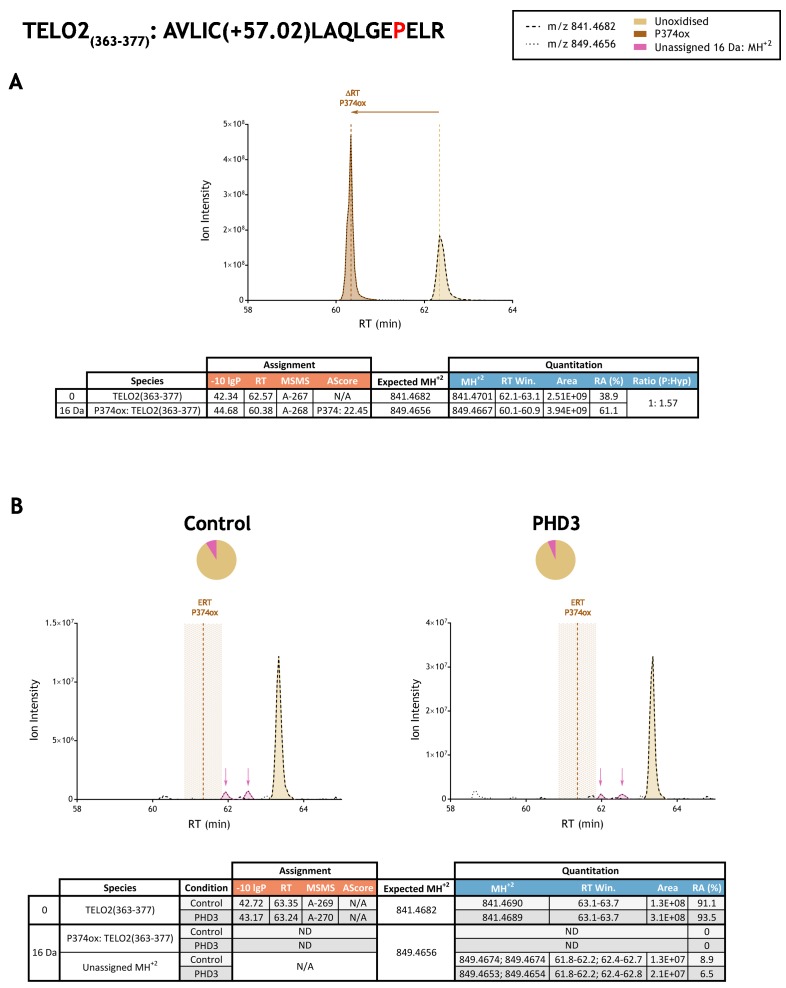
Quantitation of peptide oxidation on TELO2(363–377) following reaction of full-length telomere maintenance 2 with recombinant PHD3.XIC data presented in (A) shows ion intensity and retention time (RT) characteristics of equimolar synthetic peptide standards for unoxidised and P374ox forms of the TELO2(363–377) peptide. MSMS assigned species are coloured (see inset); vertical dashed lines define peak maxima used to derive ΔRT values for P374ox. Panel (B) shows comparable XIC data for protease-digested IVTT substrate under control (left) or PHD3-reacted (right) conditions. Peaks corresponding to unoxidised TELO2(363–377) were assigned by MSMS (see inset for colour code); P374ox was not detected. The estimated RT (ERT) for P374ox, derived from (A), is indicated by dashed vertical line, shading corresponds to a 1 min RT window. Unassigned ions of compatible mass over charge for hydroxylation were observed across the elution window but their relative abundance was unchanged following reaction with PHD3 (pink arrow). Quantitative data for observed species are presented as pie charts with XIC data. Assignment and quantitation data are tabulated below each panel, table headers are as follows: (−10lgP) significance score of leading assignment at given (RT) with ambiguity score (AScore) for PTM localisation and reference to primary MSMS data in Supplementary file 1. Quantitative data reports ion counts (Area) of observed masses (MH+2) integrated over time (RT Win.), expressed as relative abundance (RA). Data on detection efficiency for synthetic peptides (Panel A, P: Hyp) is an aggregated ratio of prolyl (P) to hydroxyprolyl (Hyp) containing species.